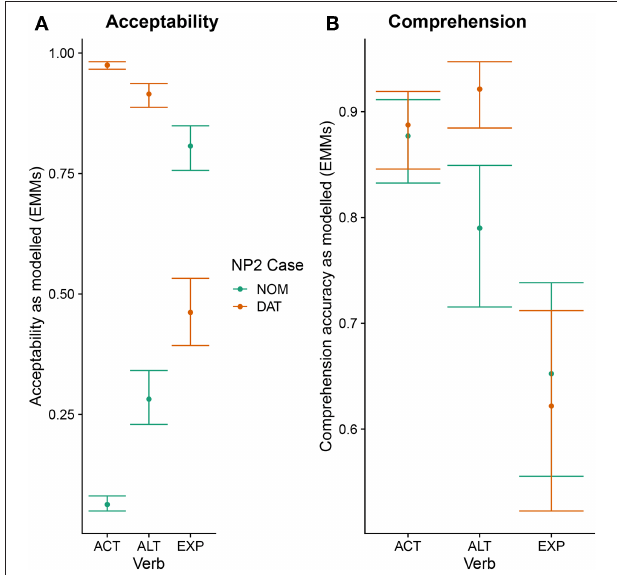
FIGURE 2 | Estimated marginal means for the fitted acceptability judgement responses (A) and fitted comprehension question responses (B) . Errorbars correspond to 83% confidence